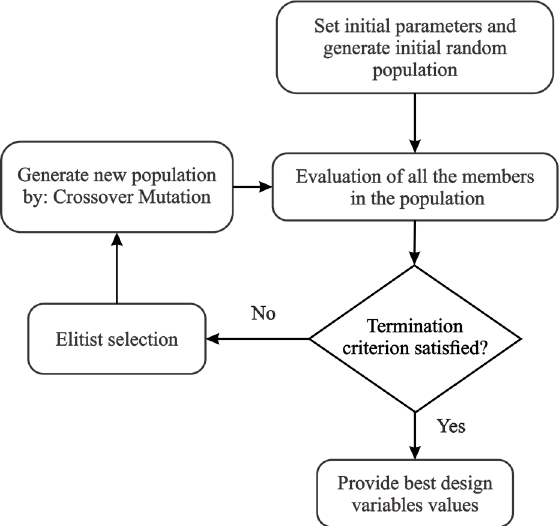
Figure 2. General scheme of the Standard Genetic Algorithms (SGA).